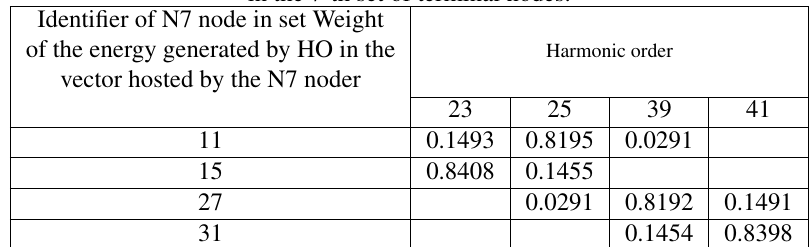
Table 4. Weights of the energies generated by the harmonics in the 7-th set of terminal